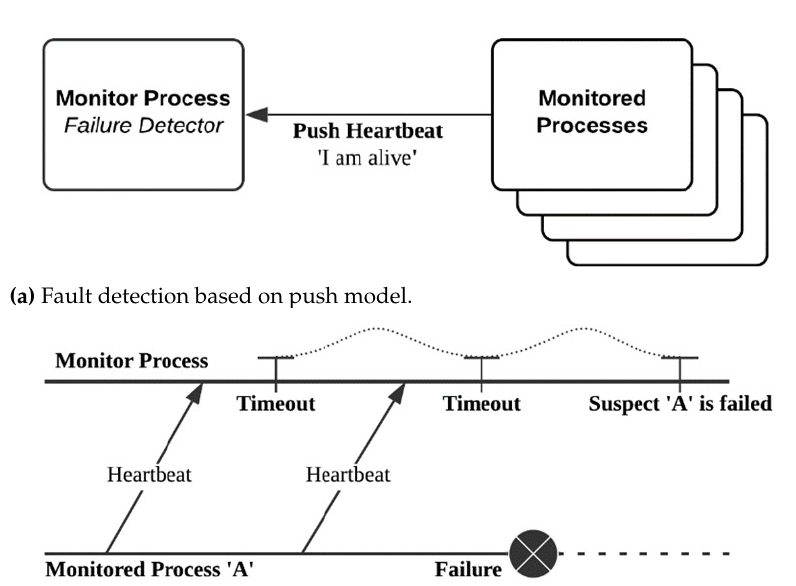
Figure 2. Fault detection in Hadoop